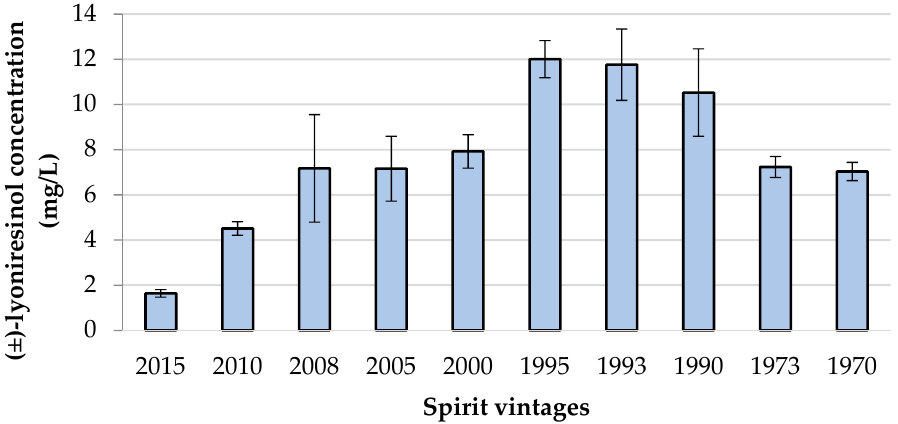
Figure 5. Concentrations of ( ± )-lyoniresinol in 10 vintages of cognac “eaux-de-vie” coming from the same distillery.